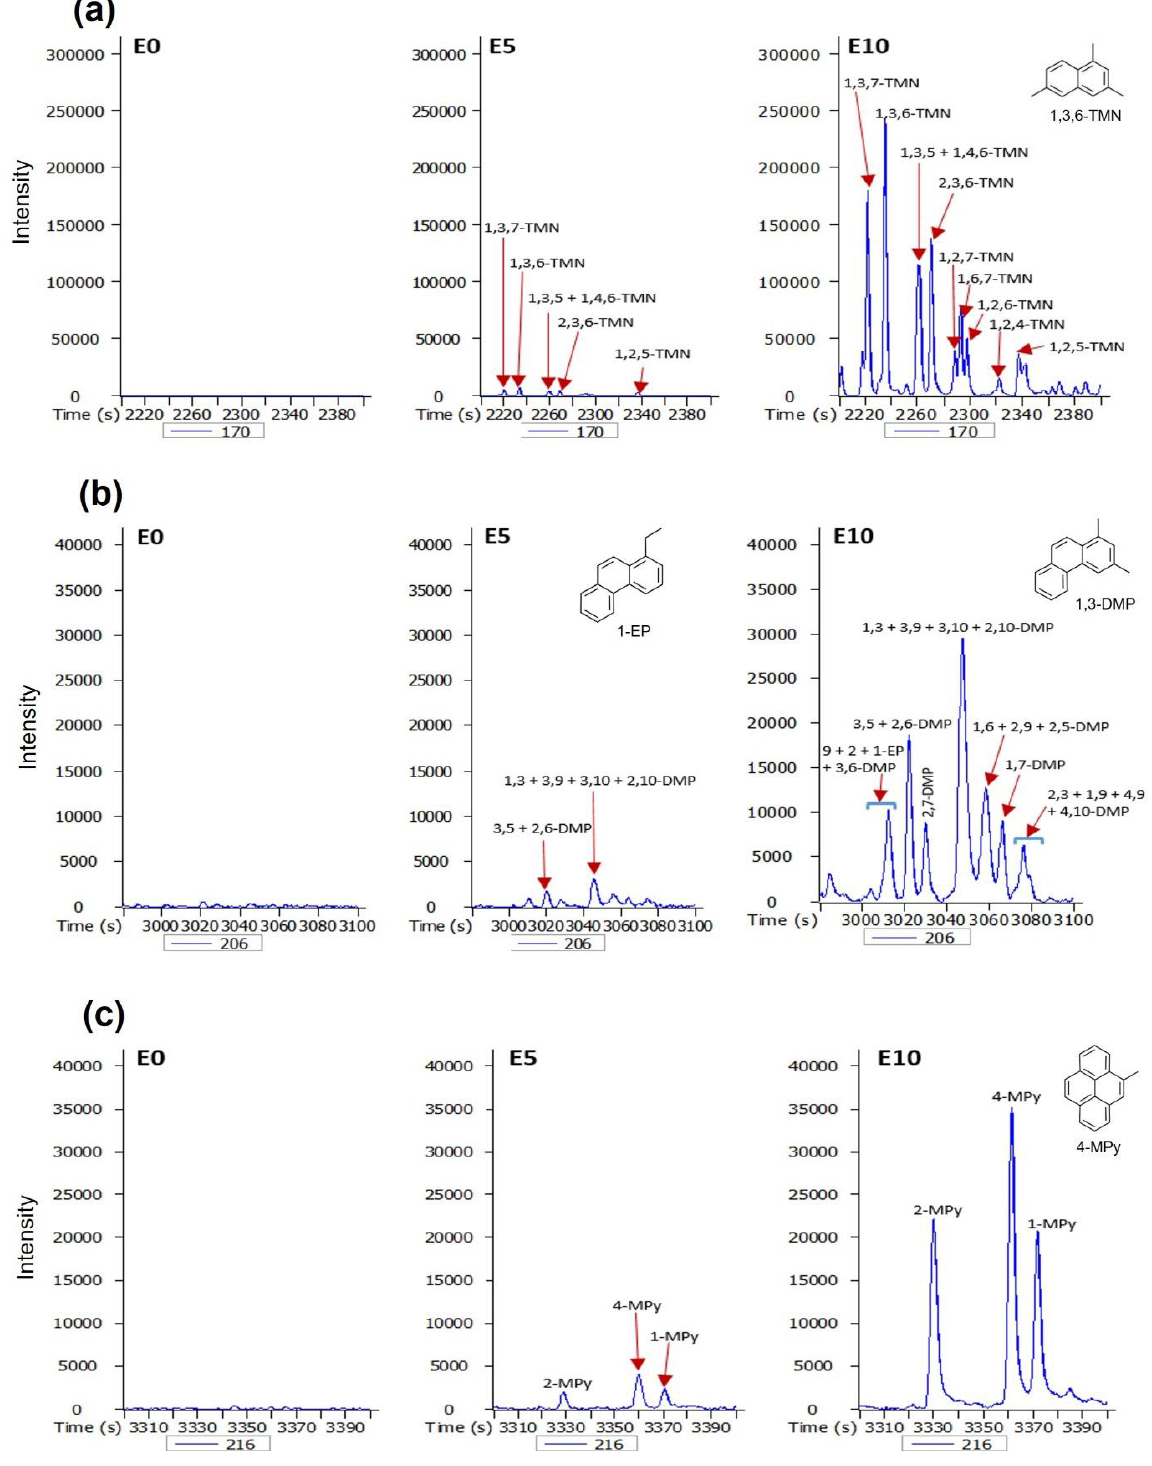
Figure 1. Partial ( a ) m/z 170, ( b ) m/z 206, and ( c ) m/z 216 mass chromatograms of the E0, E5, and E10 leachates, showing identification of the trimethylnaphthalenes (TMN), dimethylphenanthrenes (DMP) and ethylphenanthrenes (EP), and methylpyrenes (MPy), respectively. The detection of both DMP and EP at m/z 206 was due to their having the same molecular mass. Numbers denote the positions of alkylation.